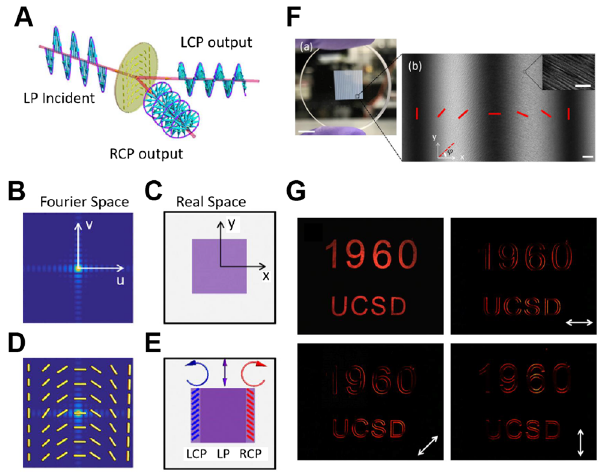
Figure 8: Edge detection using Pancharatnam – Berry (PB) phase gradient metasurfaces [41]. (A) The concept of PB phase. Upon illumination of an incident linearly polarized (LP) beam, the PB phase metasurface splits the light into left-handed circularly polarized (LCP) and right-handed circularly polarized (RCP) beams with opposite directions. The Fourier space spectrum (B) and real-space image (C) of a square object. When a PB phase gradient metasurface is added at the Fourier plane, (B) and (C) change to (D) and (E), respectively. (F) The fabricatedmetasurfacewithapatternareaof8 × 8mmembeddedin a 3-mm-thick glass substrate (scale bar is 5 mm). The polariscope optical image of the area marked in the left panel is shown in the right panel (scale bar is 25 μ m). The constituent elements in one period of the metasurface are indicated by the red bars in the right panel, and the inset shows the SEM of the fabricated device (scale baris500nm).(G)Thetopleftpanelshowstheoriginalimage,while other three panels show detected images at the output of the system. Different orientation of the intermediate metasurface, which is indicated by the white arrows, resolves different portion of